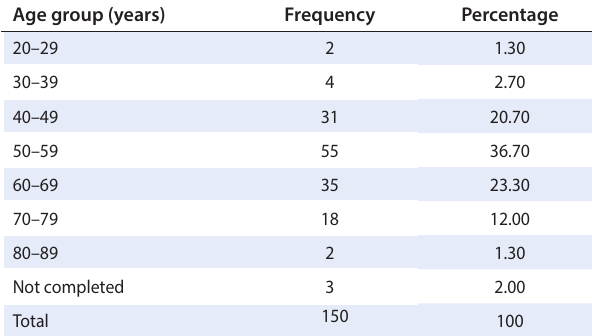
Table 1: Age groups Age group (years)